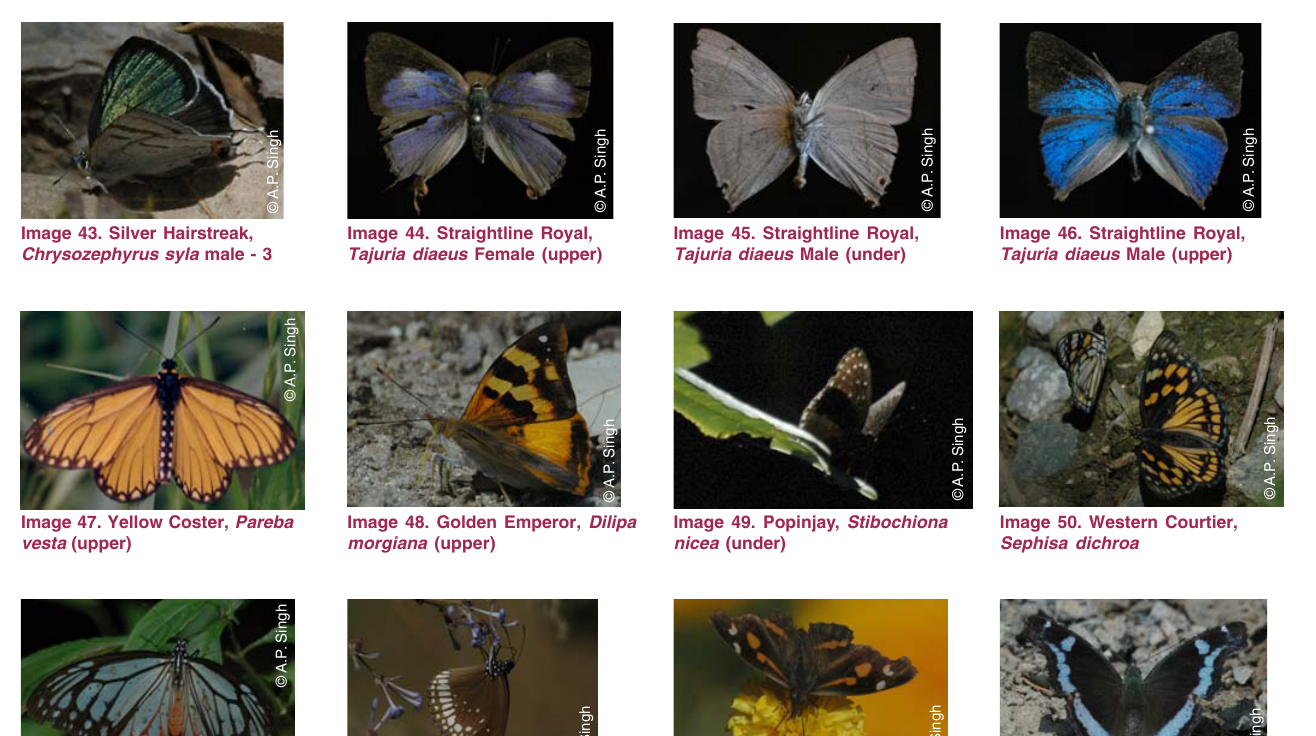
Image 51. Chestnut Tiger, Parantica sita